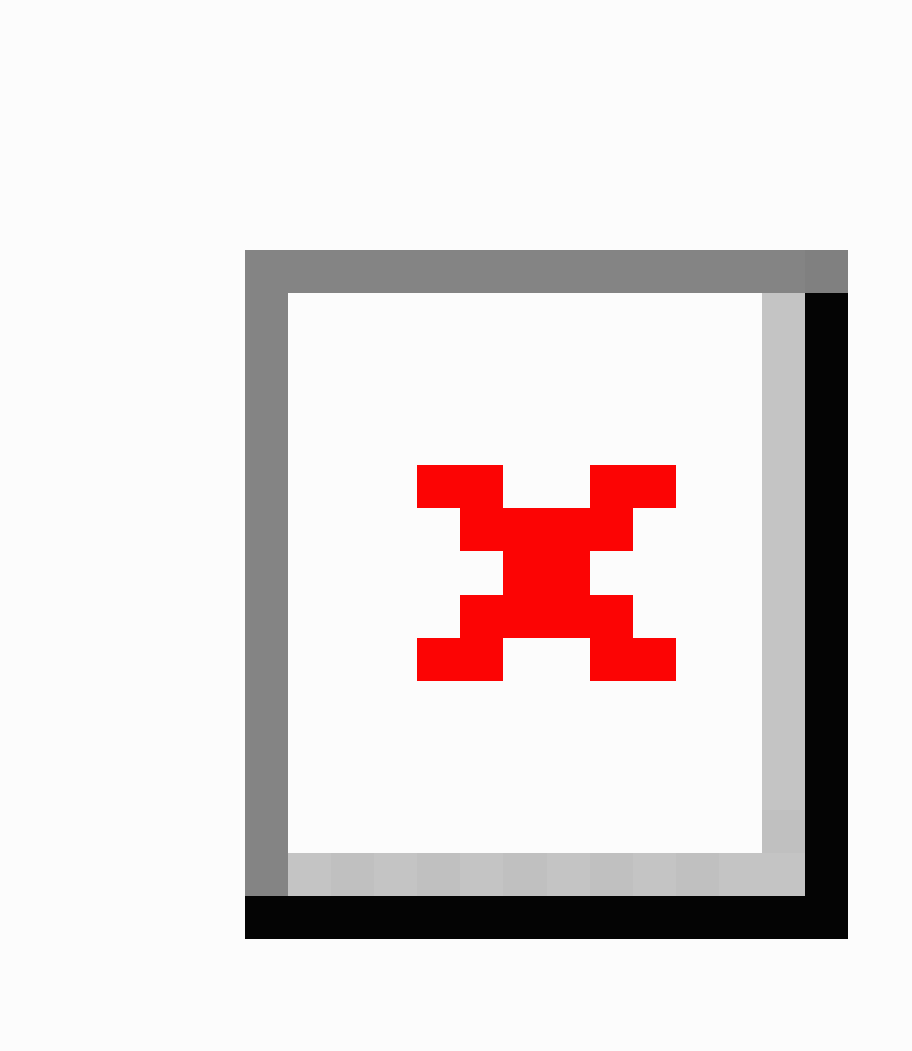
Figure 1. Microsoft Academic Search